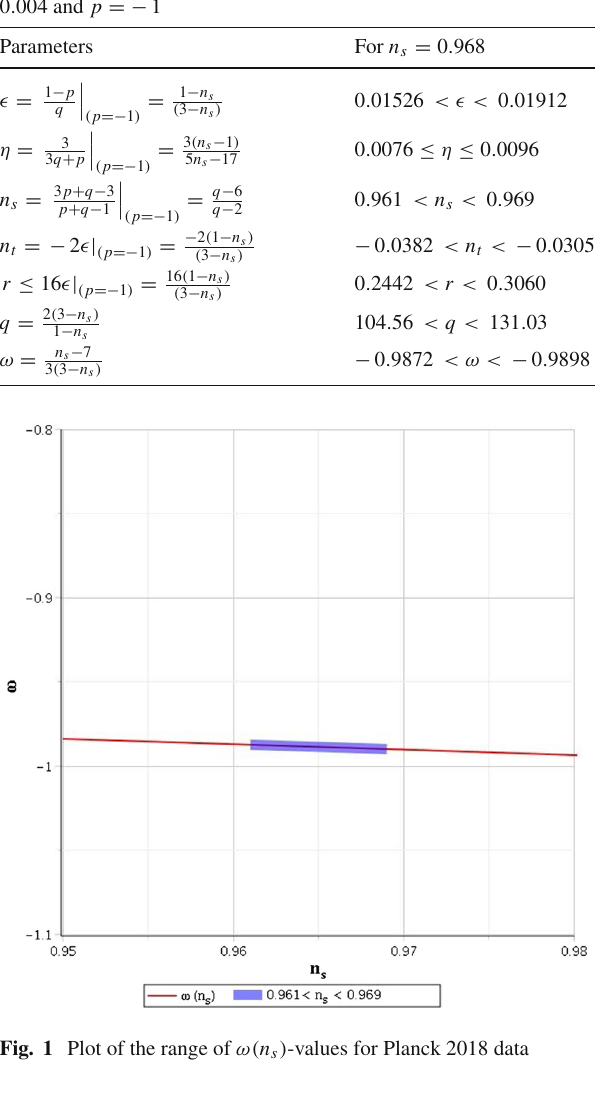
Table 1 Observational cuts for slow-roll parameters for n s = 0 . 965 ± 0 . 004 and p = − 1